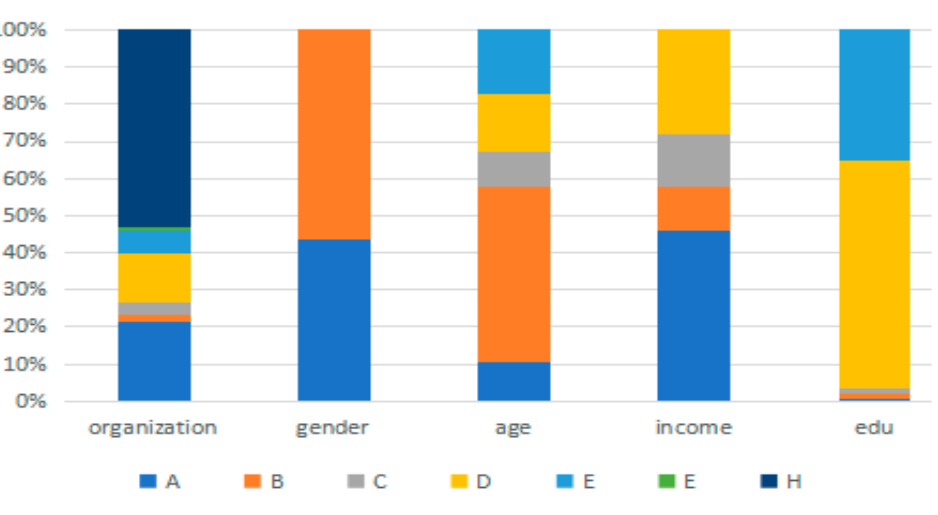
Figure 2. Basic demographic characteristics of the consumers.